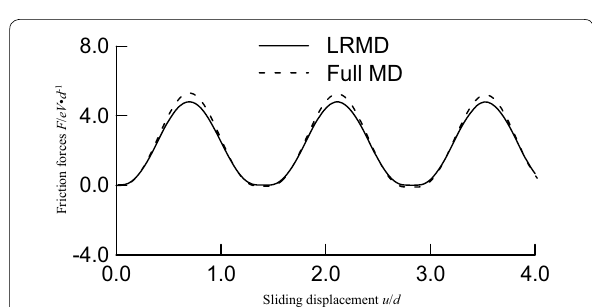
Figure 8 Friction forces comparison between LRMD simulation and